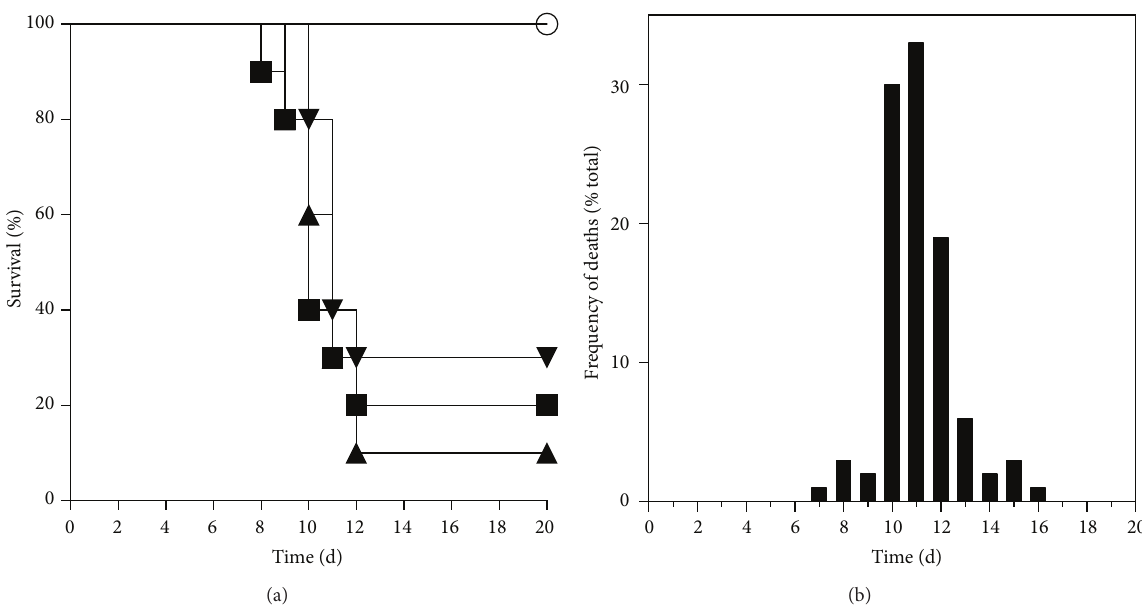
Figure 1: Standardization of mouse cutaneous herpes model. (a) Three different experiments performed with 5.0 × 10 4 PFU of HSV-1 (closed symbols). In each experiment, infected mice showed significantly lower survival than controls (open circles; log-rank Mantel-Cox test; 𝑃 < 0.001 ). (b) Frequency of deaths from the experiments shown in